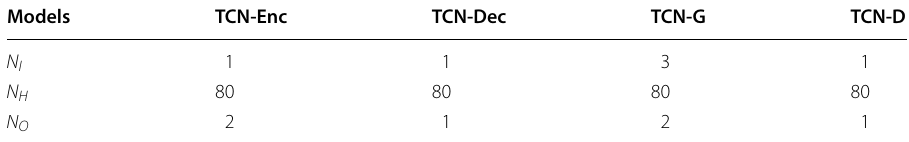
Table 9 Configuration of the encoder (Enc), decoder (Dec), generator (G) and discriminator (D) of the FinGAN